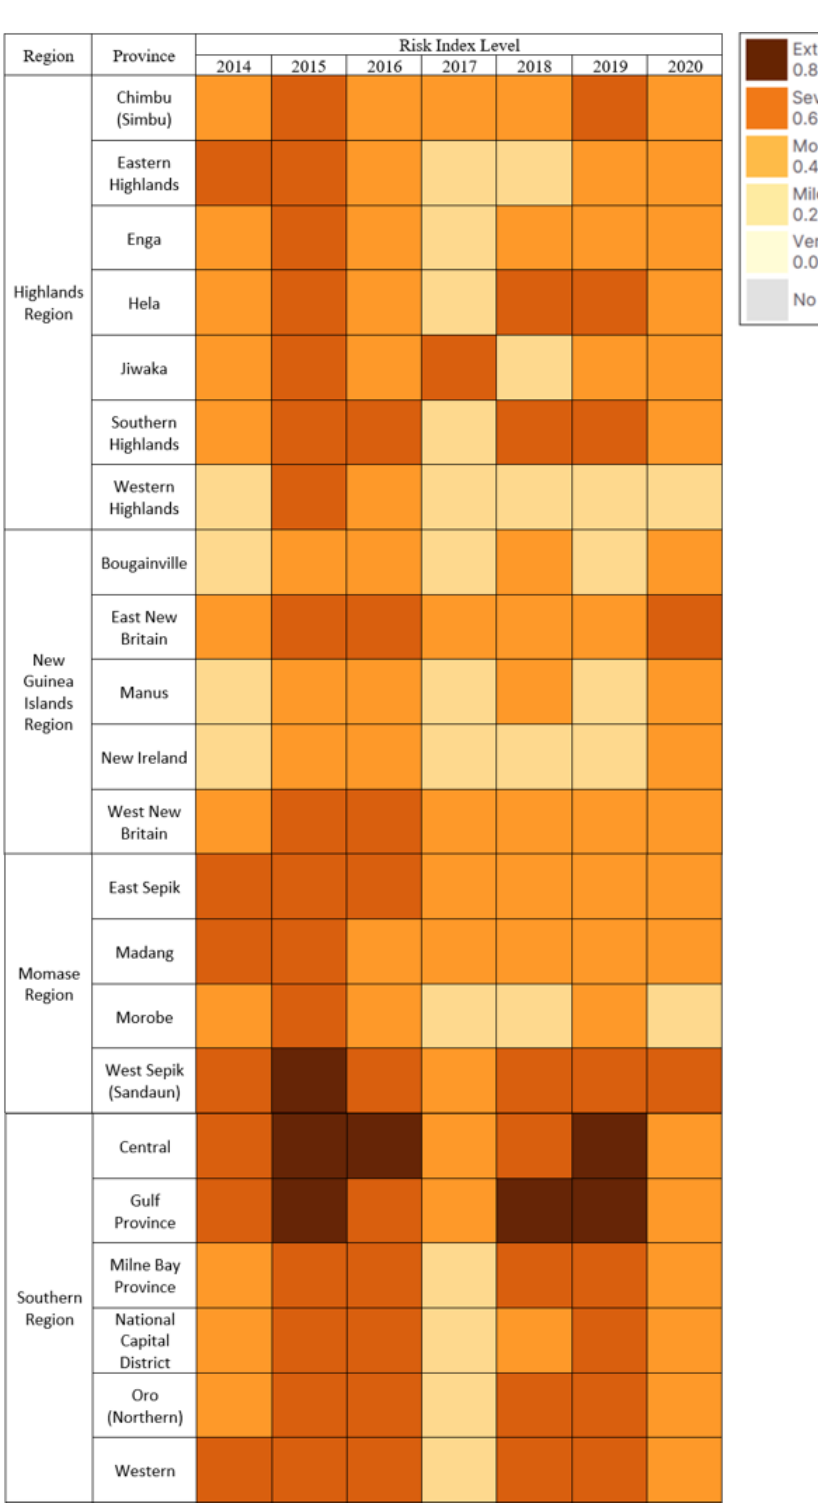
Figure 4. Risk index levels for each PNG province calculated from the drought risk assessment conducted for 2014, 2015, 2016, 2017, 2018, 2019, and 2020. Risk index levels are classified on a deepening orange colour scale from very mild (index values from 0.01–0.20) to extreme (index values from